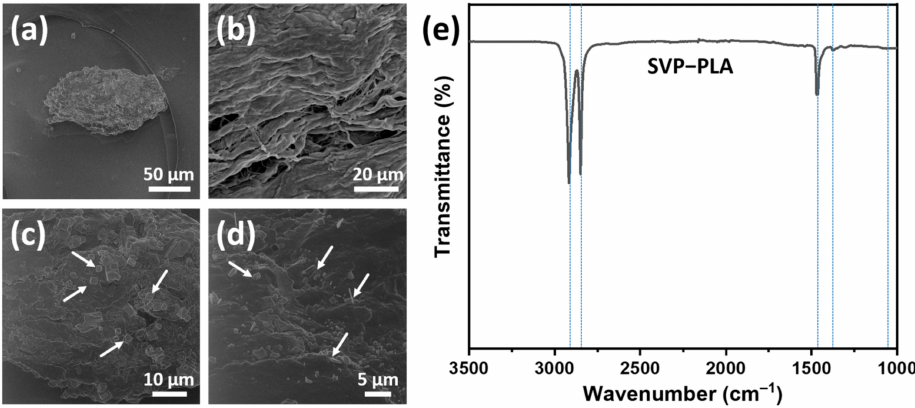
Figure 3. ( a – d ) Helium ion microscopy (HIM) images and ( e ) FTIR spectra of the SVP-PLA